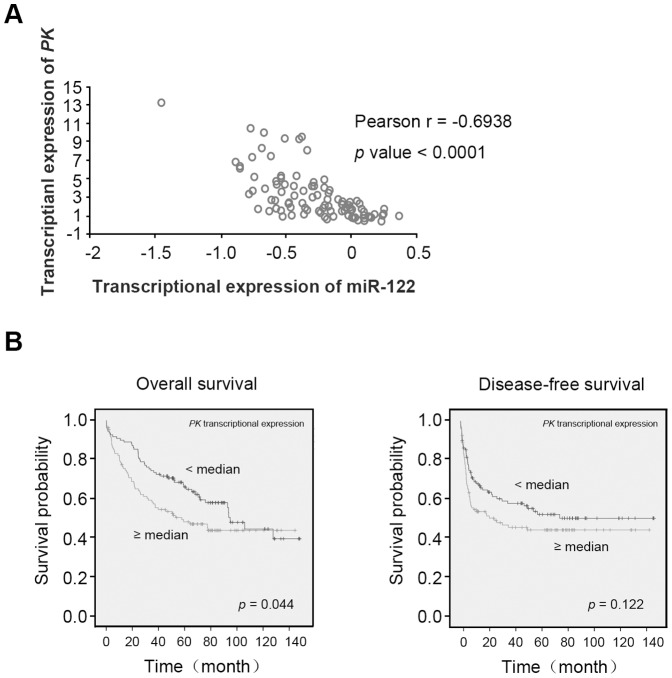

PK is anti-correlated with miR-122 expression in HCC tumors and correlates with outcome of HCC patients.(A) Transcriptional expression correlation of PK and miR-122 in 94 human HCC tumor samples. (B) Kaplan-Meier overall survival (left panel) and disease-free survival (right panel) analyses of 217 HCC patients, based on PK transcript level. Patients were divided into two groups: 1) higher than the median PK expression level, 2) lower than the median PK expression level.